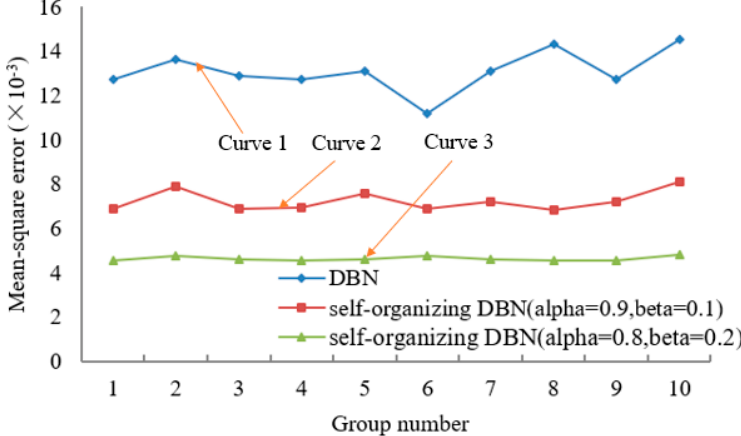
Figure 10. Comparing different methods.